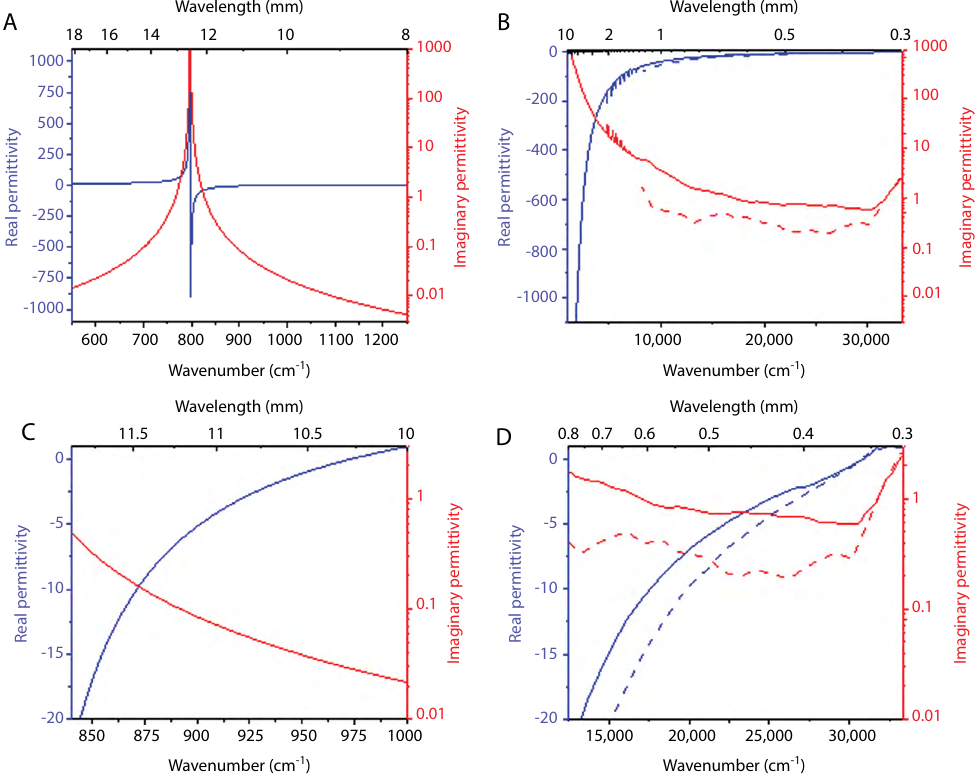
Figure 3 Real (blue) and Imaginary (red) permittivity (A) calculated for the 4H-SiC epitaxial layer from Ref. [57] and (B) of silver as calculated by Palik [89] (solid lines) and Johnson and Christie [90] (dashed lines). A magnified view of the spectral region where the 0 ≥ Re( ε ) ≥ -20 is presented in (C) and (D),